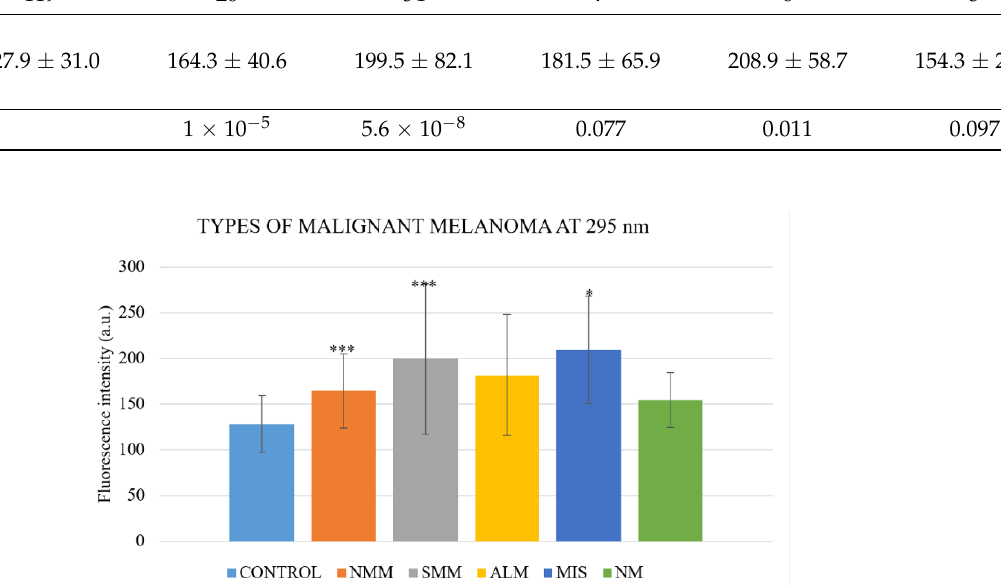
Table 2. Statistical analysis of types of malignant melanoma compared to the control group. For evaluation of differences, Student’s t- test was used. Values of fluorescence intensity are expressed as mean ± SD.